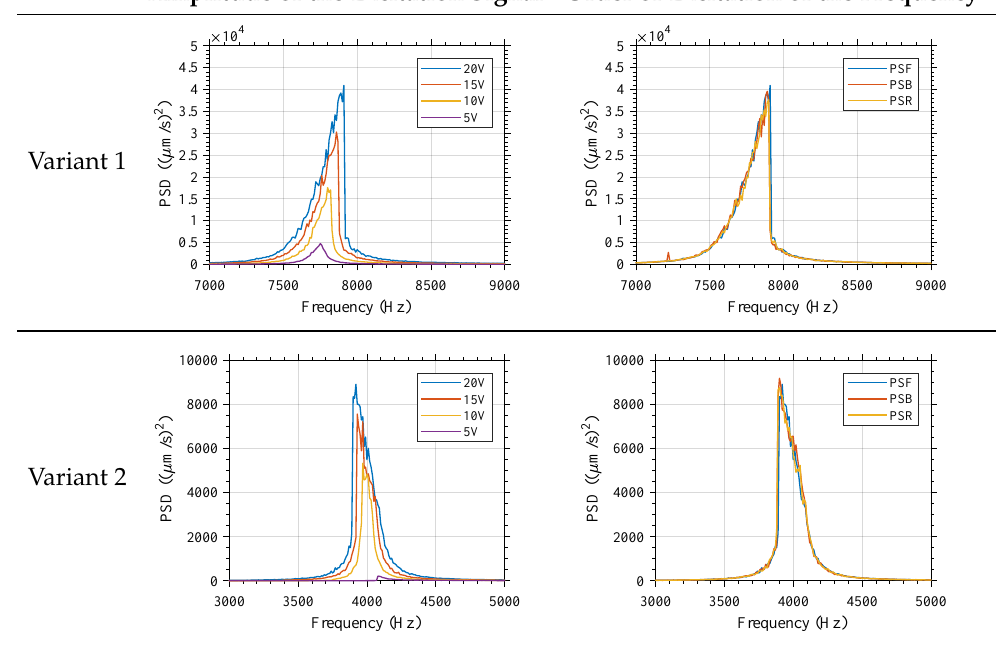
Table A3. Summary of the measurements results for the PS -type excitation. Influence of